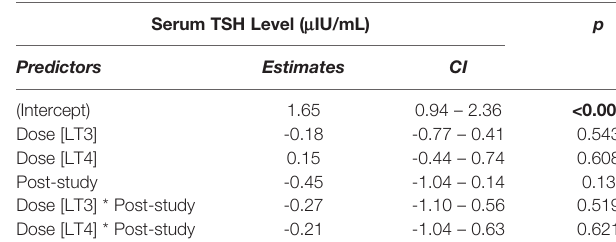
TABLE 3 | Linear mixed-effects model for changes in